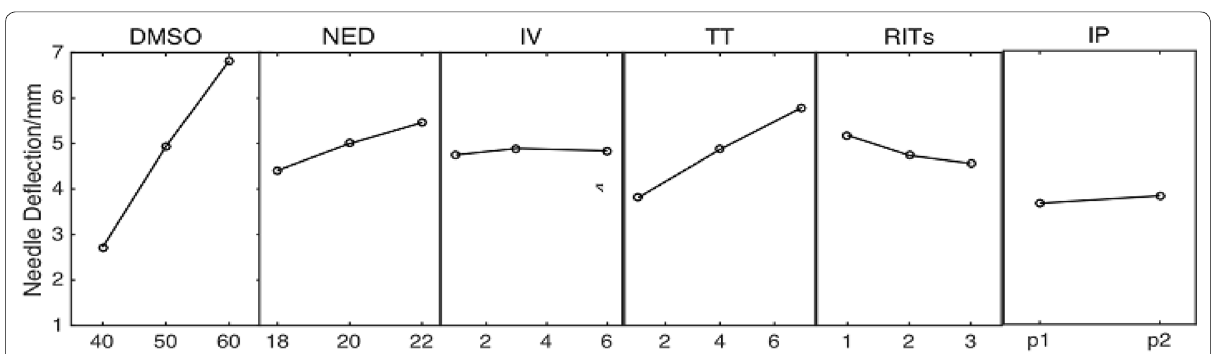
Figure 11 Main effect plot of orthogonal factor on needle